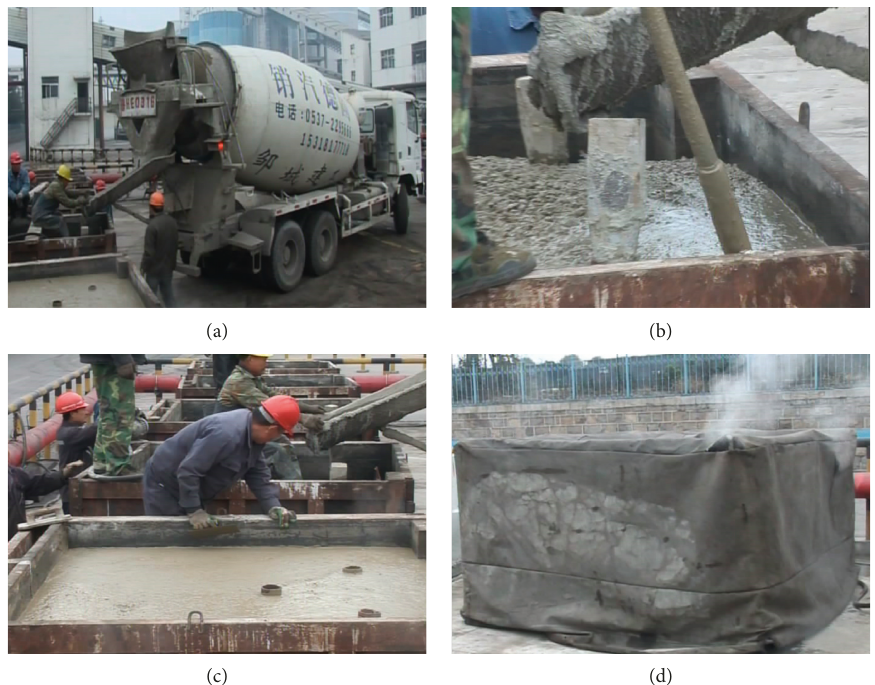
Figure 13: Pictures of production of large-size concrete blocks: (a) pouring commercial concrete material into the mould; (b) vibratory mixing of concrete; (c) formed concrete block; (d) curing of concrete